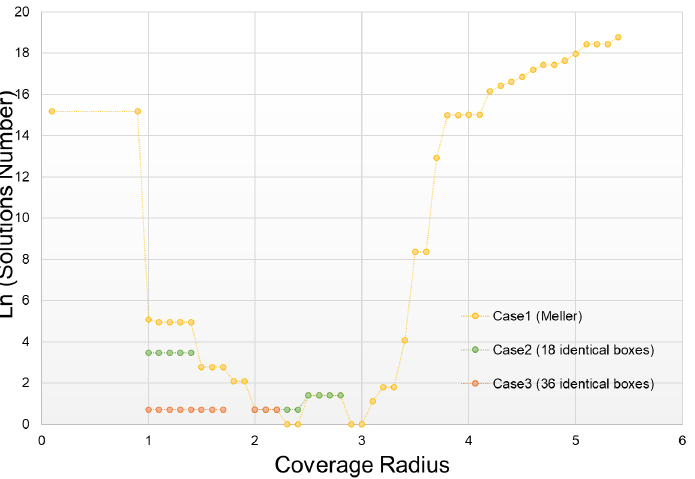
Figure 7. Enumeration of solutions according to the coverage radius (without uncertainty).